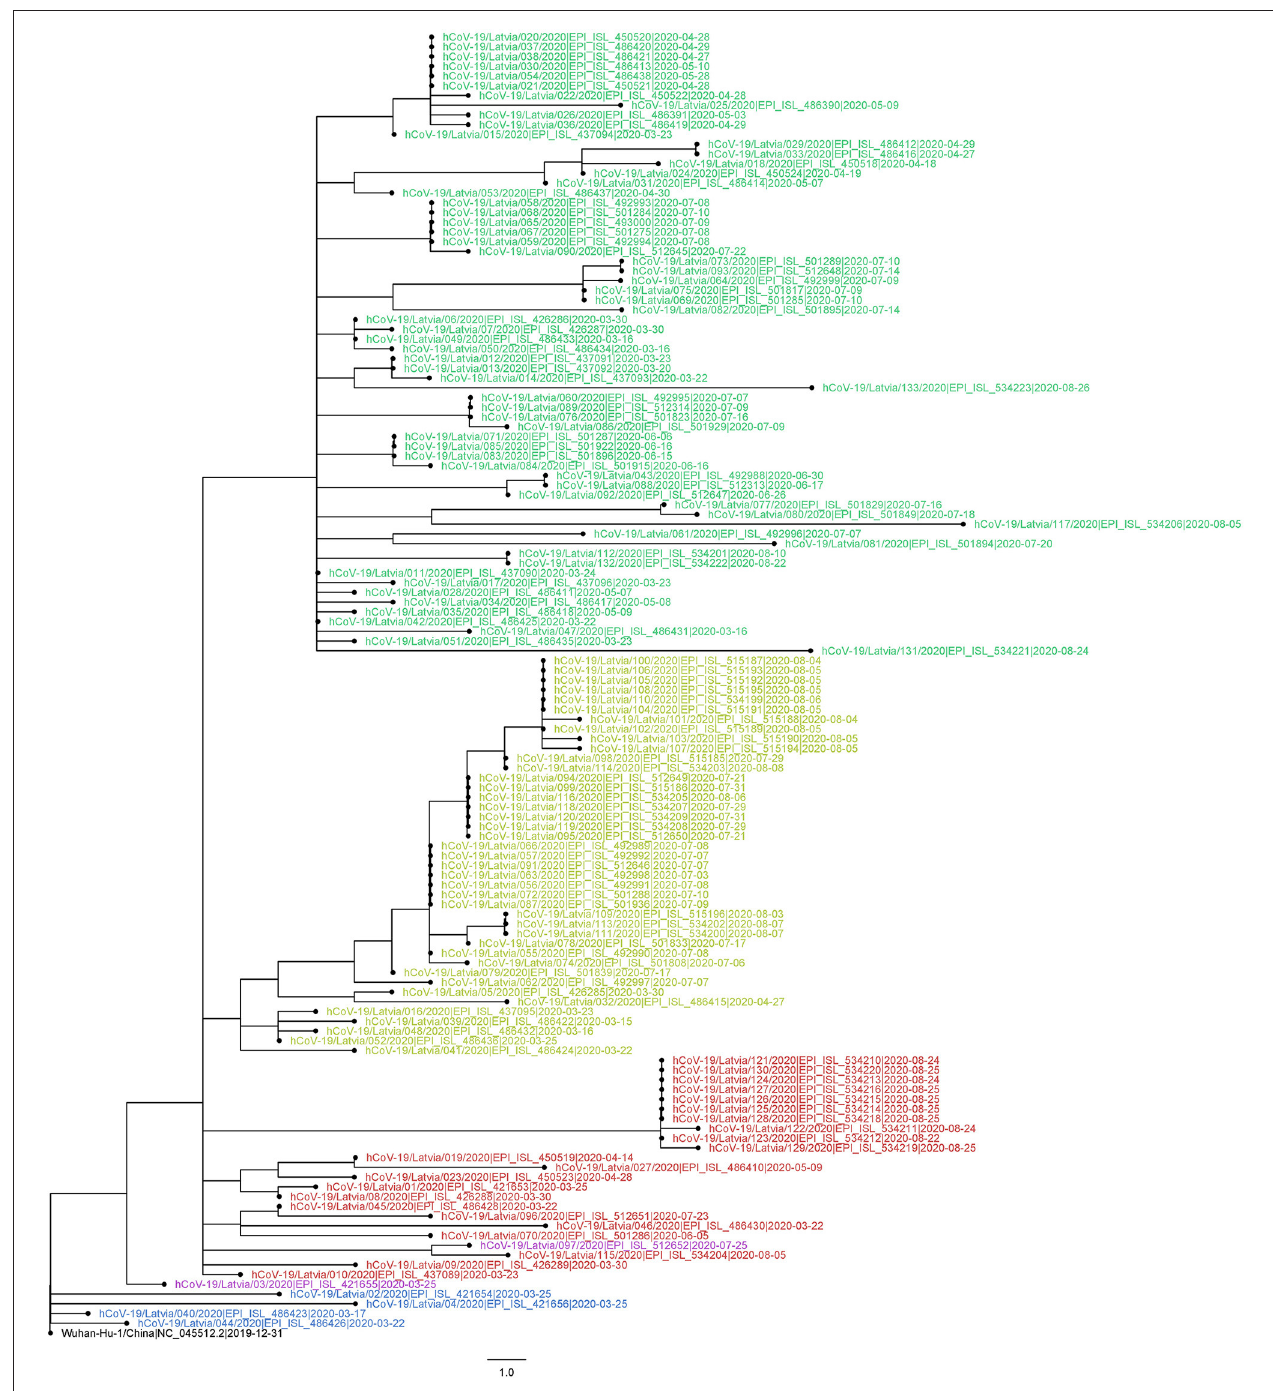
FIGURE 4 | Evolutionary relationships of 133 sequenced Latvian and Wuhan-Hu-1 SARS-CoV-2 isolates. The evolutionary history was inferred using the Maximum-likelihood method allowing for polytomies. The tree is rooted at Wuhan-Hu-1 reference sequence. The tree is drawn to scale; branch lengths correspond to nucleotide substitutions. The analysis involved 134 nucleotide sequences (133 Latvian SARS-CoV-2 isolates and Wuhan-Hu-1 reference sequence). There were a total of 29,903 positions in the final dataset. Node labels are colored according to the GISAID major clade of particular isolate, as follows: green, GR; yellow, GH; red, G; blue, L; purple, O (other); black, Wuhan-Hu-1 reference sequence.